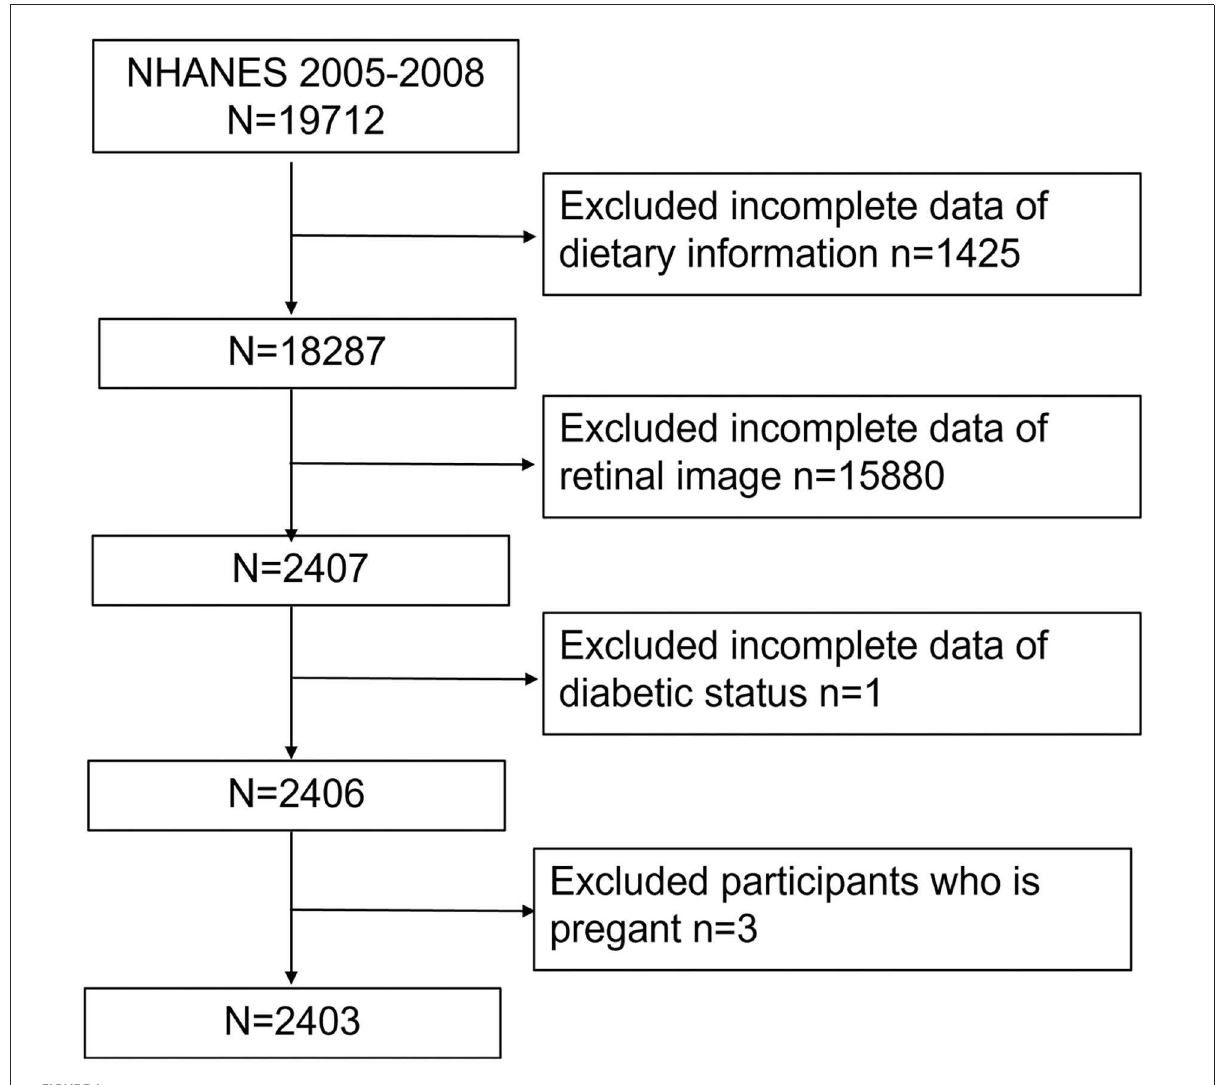
FIGURE1 Flowchart of sample selection from NHANES